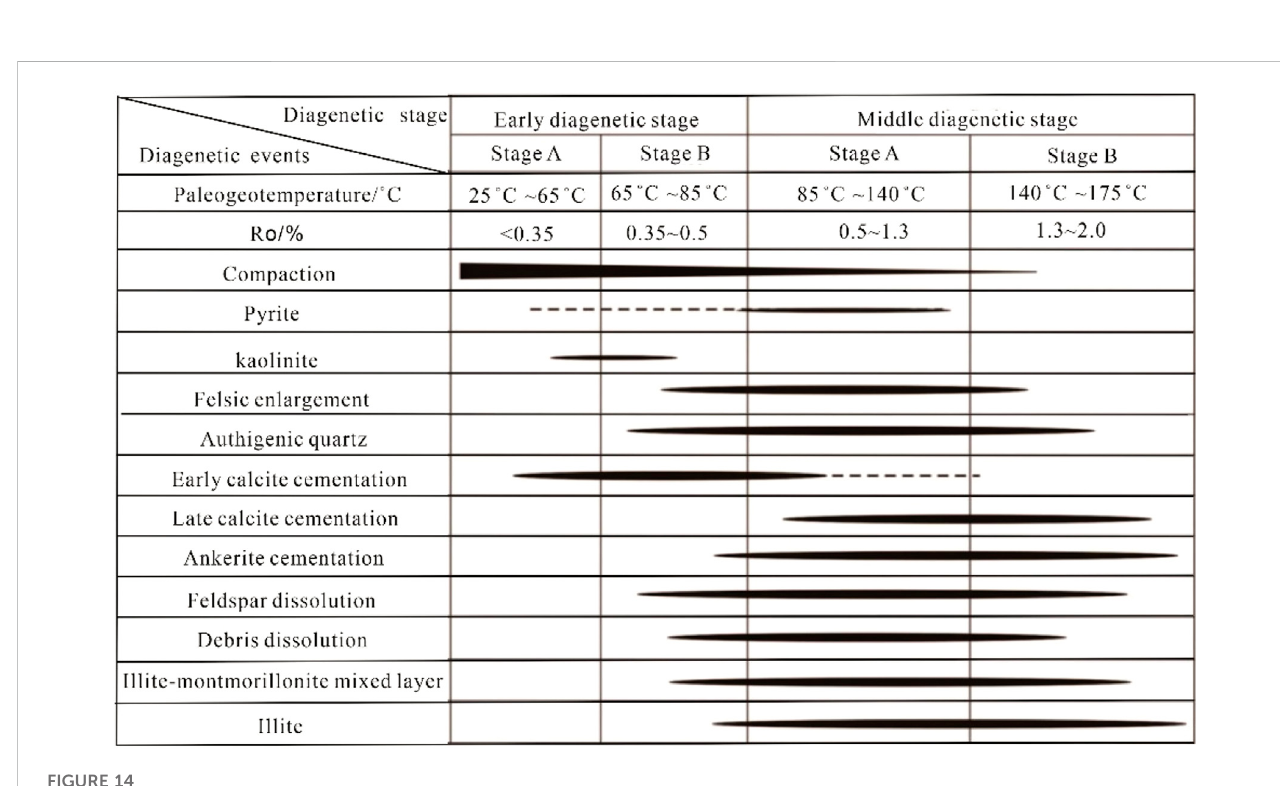
FIGURE 14 Diagenetic evolution sequence of tight sandstone of Gaotaizi oil layer in Qijia area.